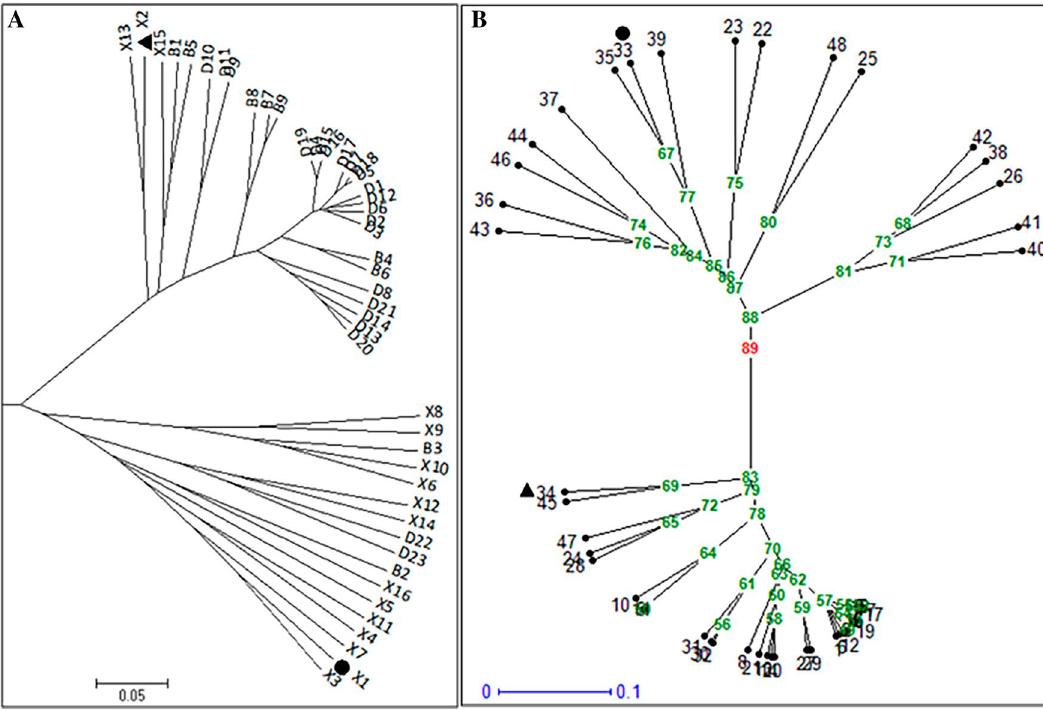
Figure 2. Radial display of phylogenetic trees constructed based on 39CPT InDel markers. Phylogenetic tree constructed using Power Marker (PM) version 3.25 software ( A ) and Darwin version6 software ( B ). The complete genome re-sequenced parents Xl and X2 of elite cucumber Lvmei No. 1 hybrid variety is highlighted with triangular and round shape in black color. The red colored number in ( B ) indicates genetic similarity score at root node of the tree. Numbers at each node in ( B ) are genetic similarity scores. In B: l = Dl , 2 = D2, 3 = D3, 4 = D4, 5 = D5, 6 = D6, 7 = D7, 8 = D8, 9 = D9, 10 = D10, 11 = D11, 12 = D12, 13 = D13, 14 = D14, 15 = D15, 16 = D16, 17 = D17, 18 = D18, 19 = D19, 20 = D20, 21 = D21, 22 = D22, 23 = D23, 24 = B1, 25 = B2, 26 = B3, 27 = B4, 28 = B5, 29 = B6, 30 = B7, 31 = B8, 32 = B9, 33 = X1, 34 = X2, 35 = X3, 36 = X4, 37 = X5, 38 =